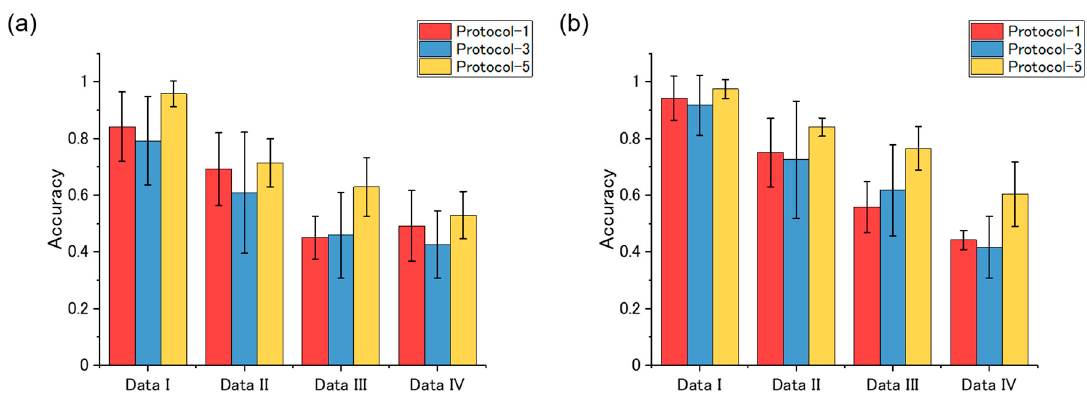
Figure 9. Summary of the classification models. Accuracies of classification models based on ( a ) logistic regression and ( b ) random forests.